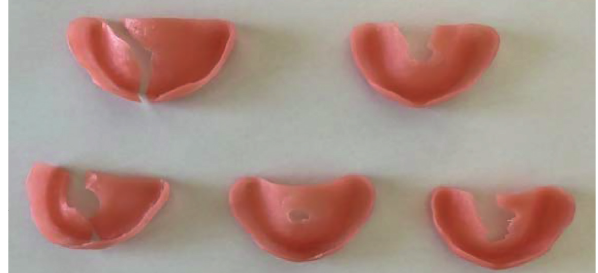
Figure 15: Triplex Hot ® prosthesis bases subjected to pH 4 after fracture.